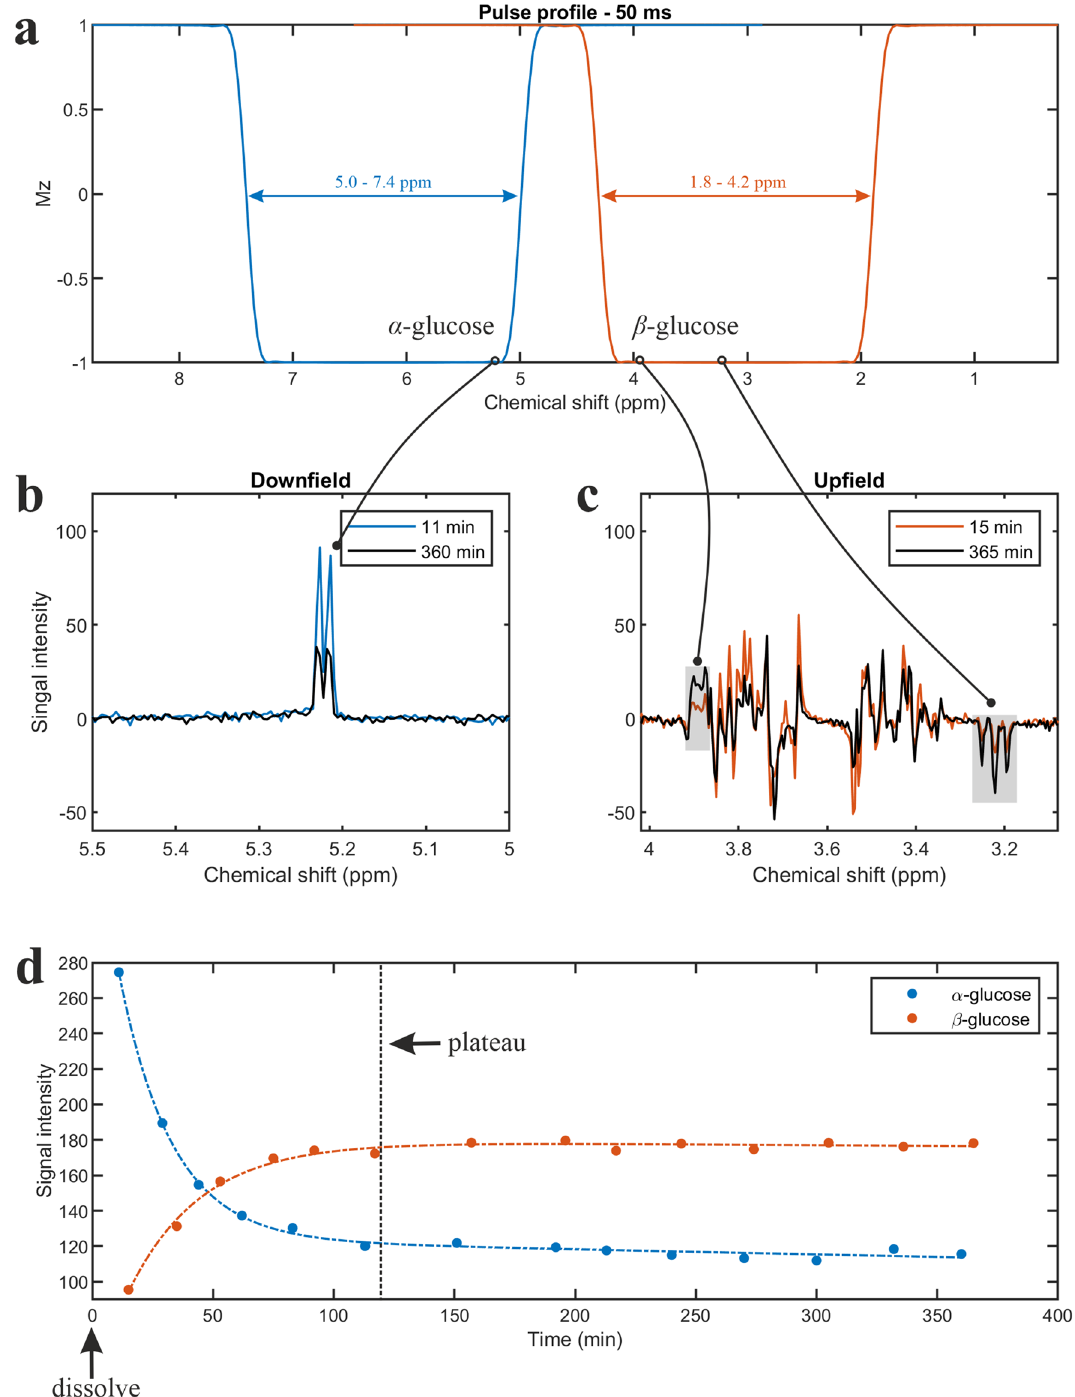
Figure 2. In vitro measurement using SLOW-editing. ( a ) Pulse profiles of refocusing/editing CSAP for downfield and upfield measurements. ( b , c ) Phantom measurements for two different time points after dissolving crystalline α-d- glucose. ( d ) Plot of peak integration of α / β-d- glucose at 5.22 and 3.88 ppm against time after dissolution of α-d-